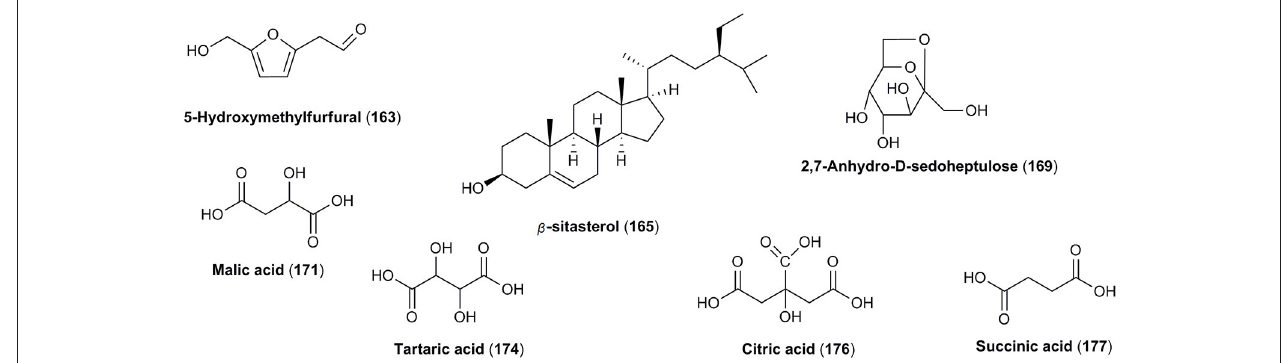
FIGURE 7 | The chemical structures of other compounds identified in fruits of C. mas and/or C. officinalis